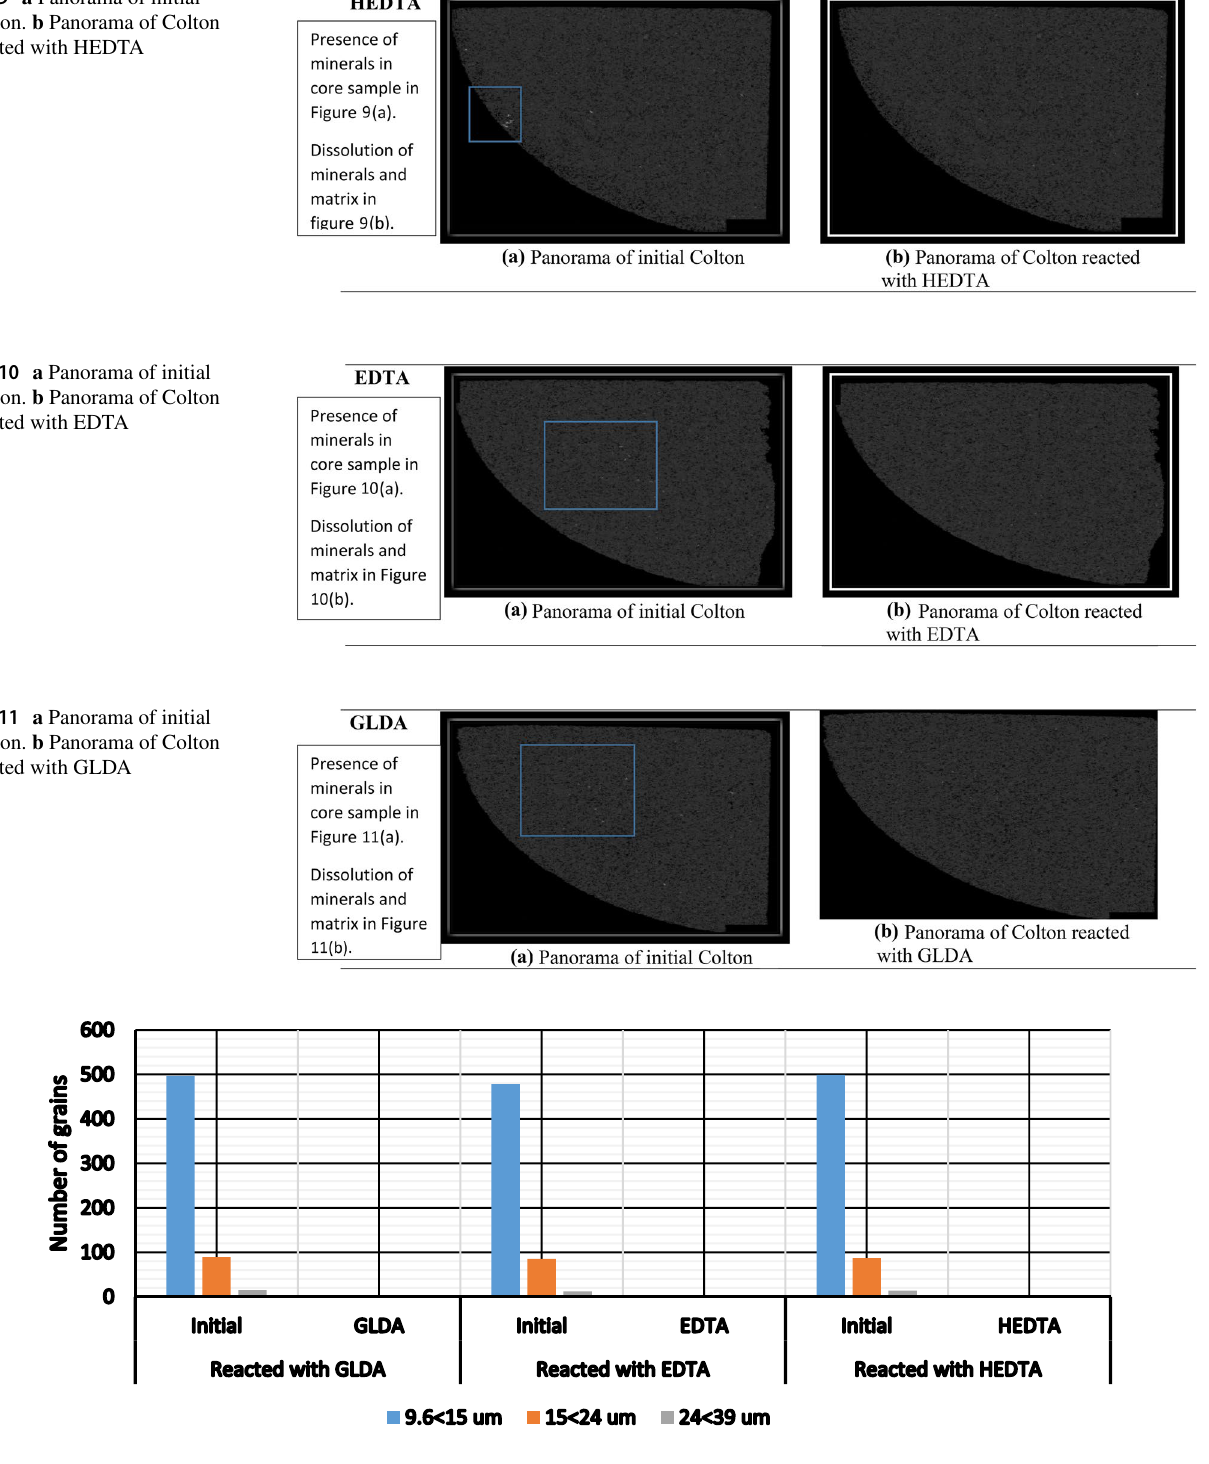
Fig. 12 The grain size distribution of Ankerite in Berea Sandstone before and after reaction with chelating